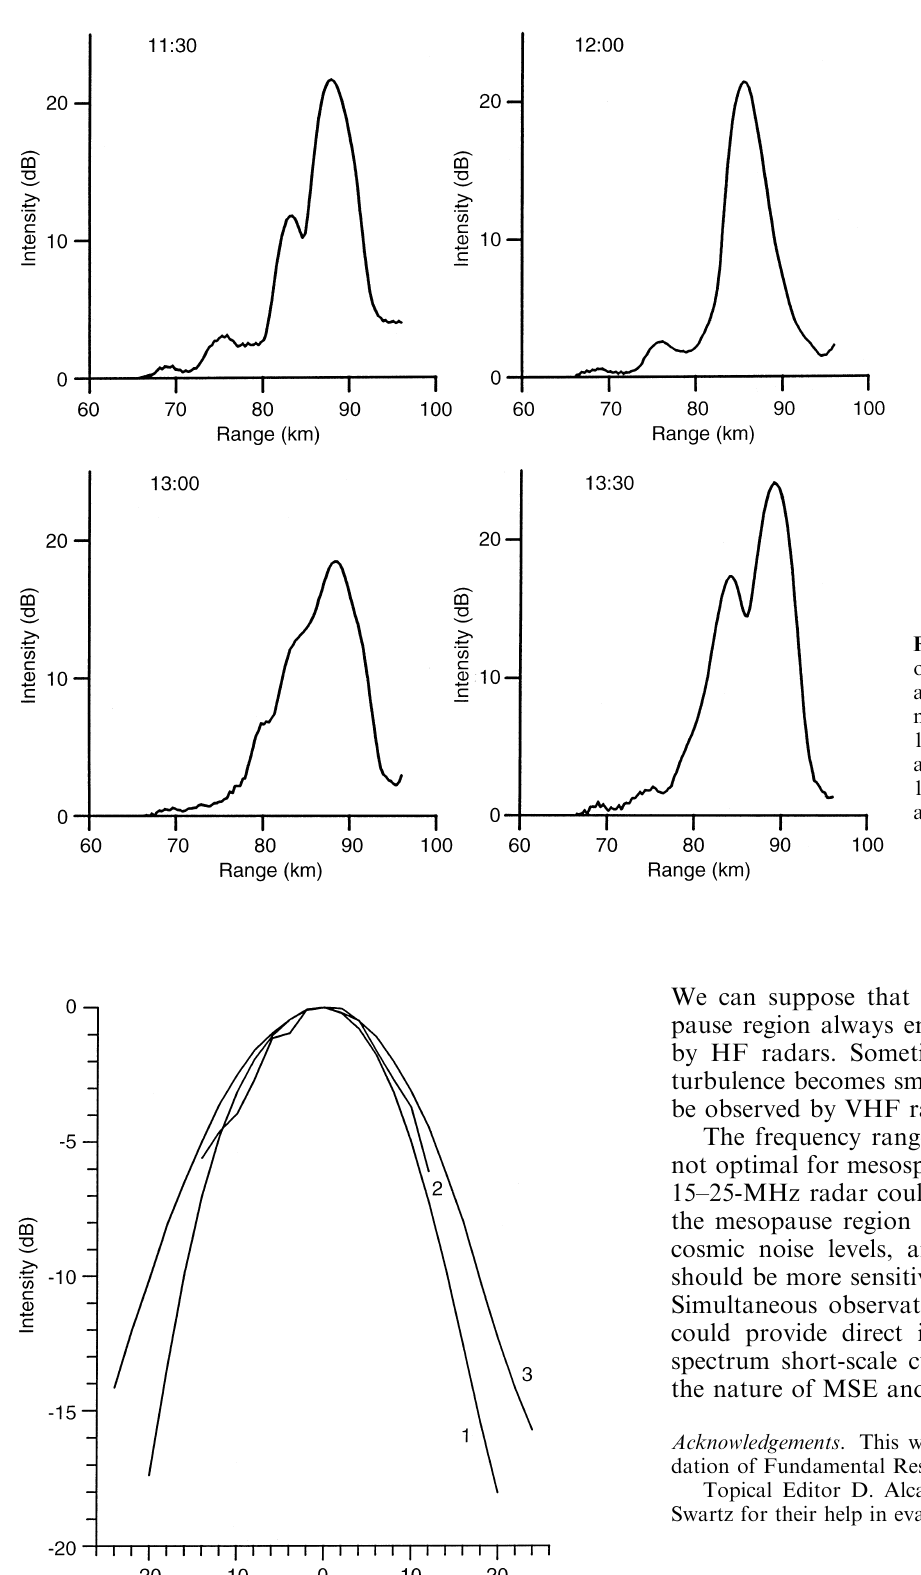
Fig. 4. Comparison between the shapes of radar returns received from isolated layer for upper (above 80 km; curve 3) and lower (below 80 km; curve 2) layers and the receiver response to the sounding pulse